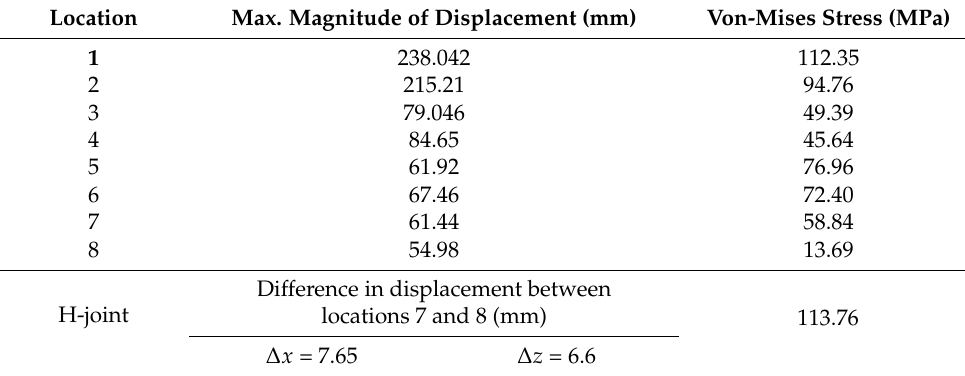
Figure 2. The measured magnitude of displacements with respect to operating time at 3DDMS locations. Table 2. Stress results estimated by CAESARII with 3DDMS